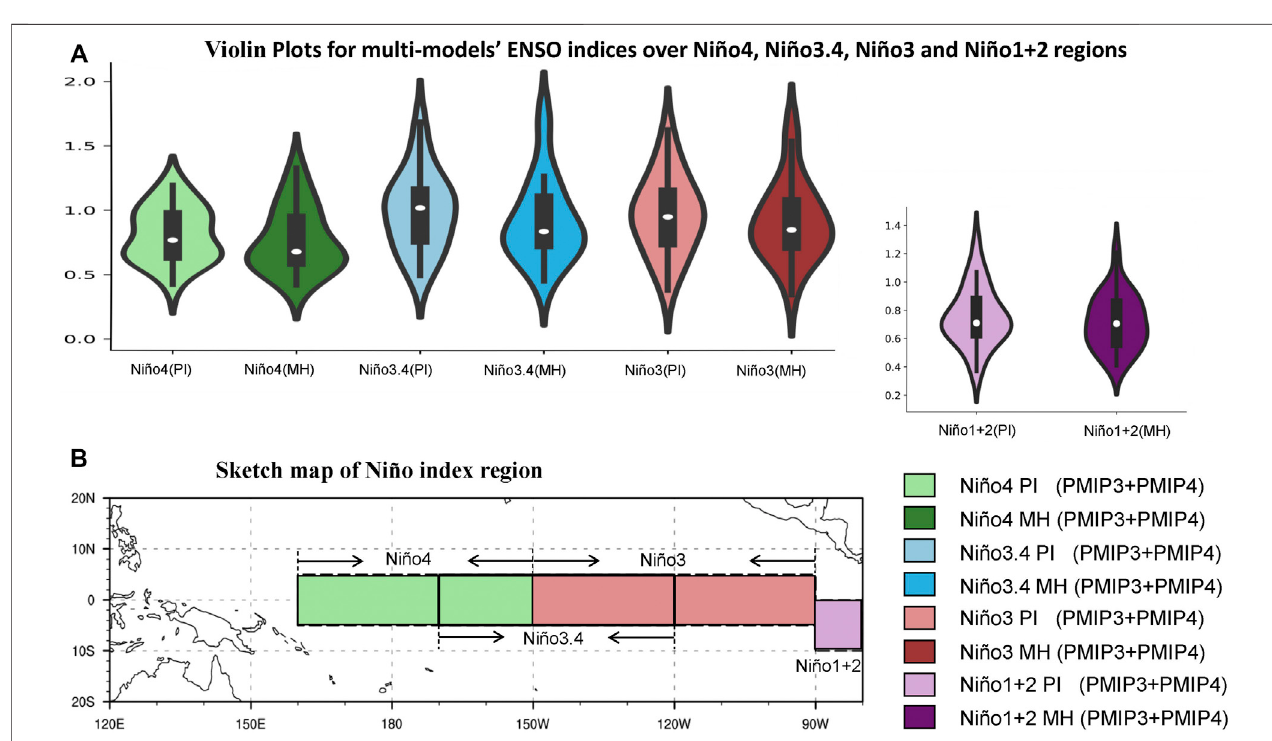
FIGURE 10 | Violin plots (A) for STD of winter (November – January) El Niño indices based on PMIP3 and PMIP4 models during the PI (light color) and MH (dark color). Unit is K. The black outline is the probability density of each index ’ s STD. The solid black boxes are the interquartile range, and the white circle in the black box is the median value. (B) is the schematic plot of ENSO index distribution region. Frontiers in Earth Science |